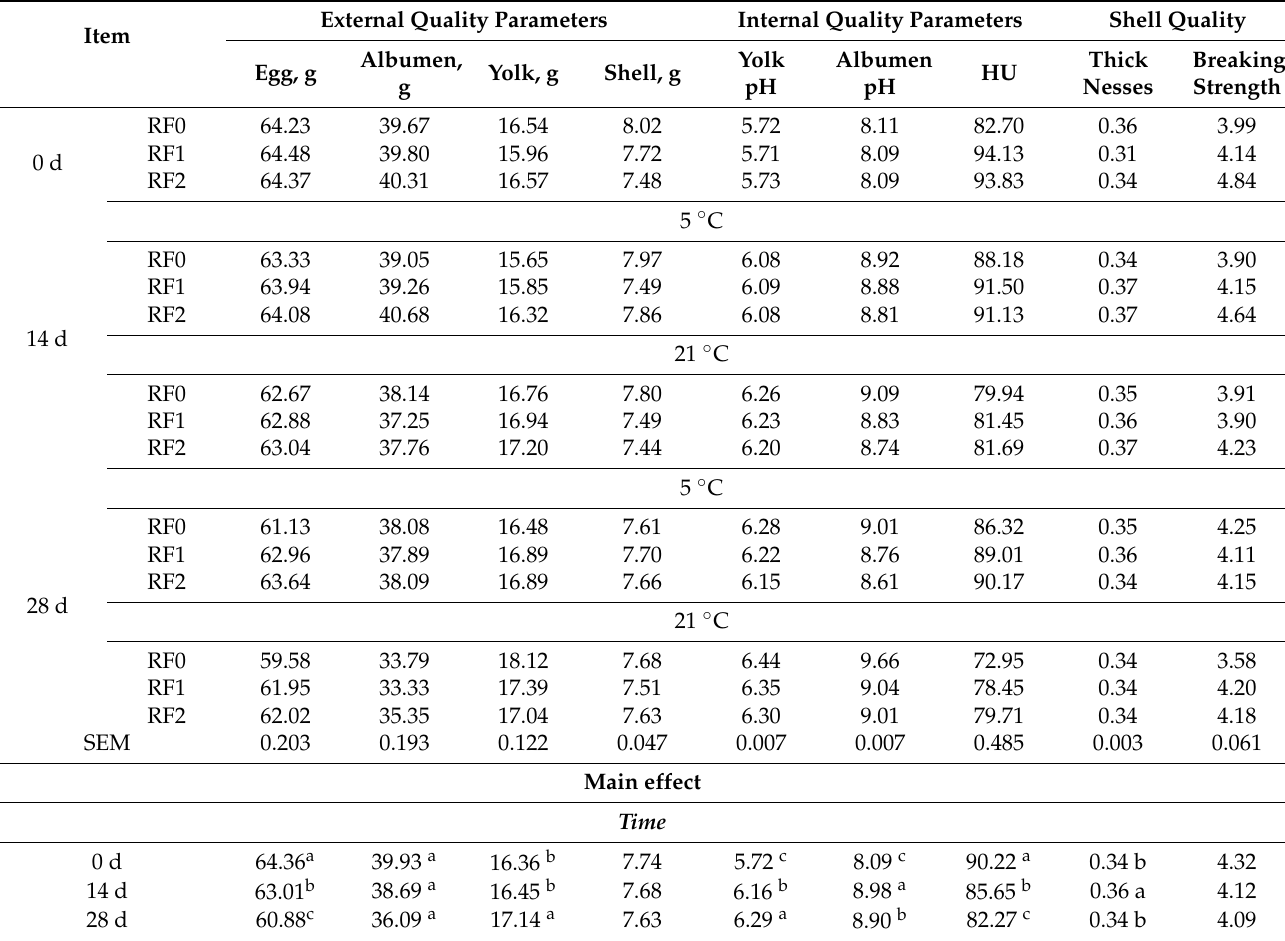
Figure 3. Effect of rosehip meal on the total antioxidant capacity determined in the egg yolk and albumen ( A ) and total polyphenols content ( B ) in polyunsaturated fatty acids enriched eggs. The significant differences ( p < 0.05) are marked in the tables by superscripts (a, b) after the 3 means were compared two by two, using the Fisher test. RF0: control diet; RF1: contains 1.5% rosehip meal and 7% flaxseed meal; RF2: contains 3% rosehip meal and 7% flaxseed meal. 3.6. Effect of Rosehip and Flaxseed Meal on Shelf ‐ Life of Eggs Table 8. Influence of rosehip meal on shelf-life of eggs stored for 28 days at 5 ◦ C and 21 ◦ The results regarding the effect of rosehip and flaxseed meals on egg quality traits and shelf ‐ life during 28 days of storage time at 5 °C and 21 °C are presented in Table 8.